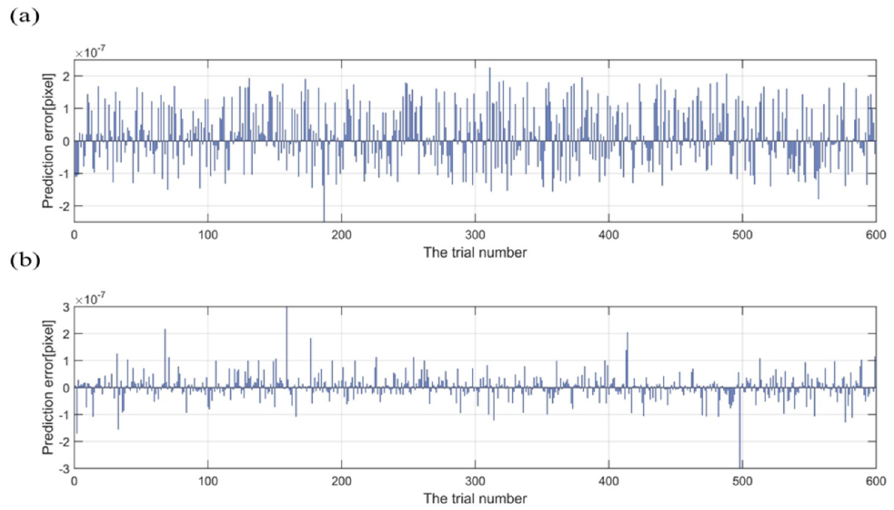
Figure 11. The prediction error of the BA-ELM compensation method. ( a ) Gaussian width σ PSF = 0.3. ( b ) Gaussian width 𝜎 (cid:3017)(cid:3020)(cid:3007) = 0.671.